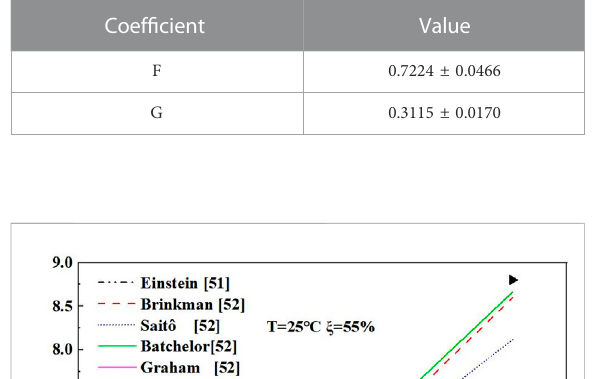
TABLE 4 Viscosity model coef fi cients of LiBr with E414.